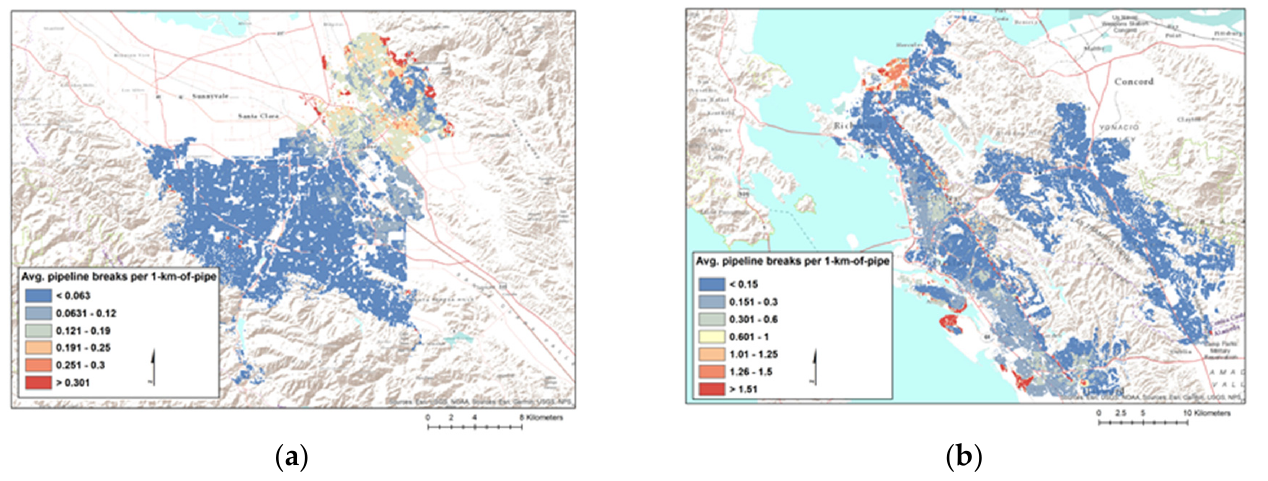
Figure 5. Interpolated (natural neighbor) average break rate per 1 km of pipe in: ( a ) SJWC and ( b ) EBMUD service areas from the CUWNet model results.